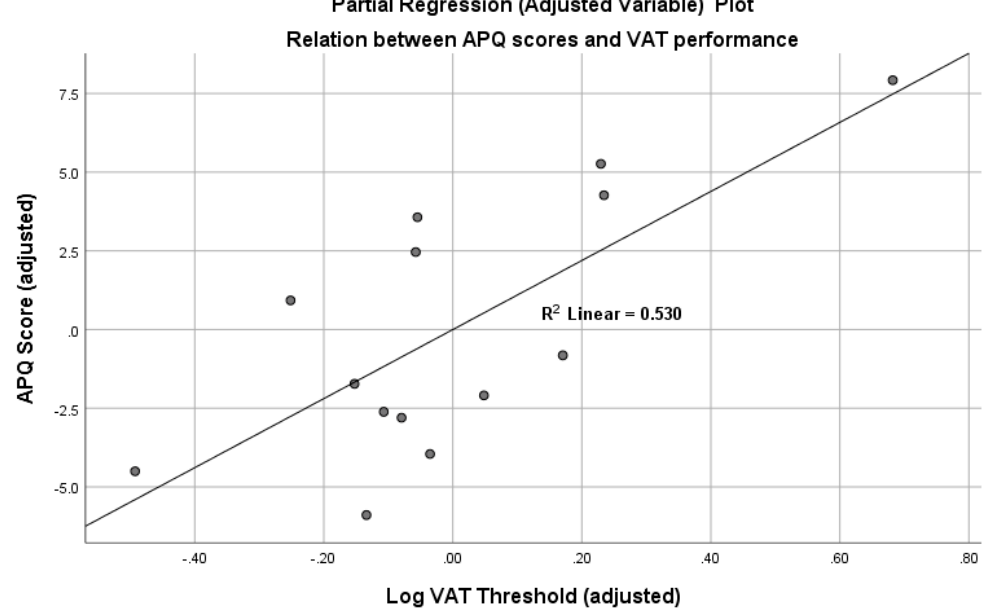
Figure 2. Partial regression (adjusted variable) plot, illustrating the relation between accident vulnerability (APQ scores) and individual differences in vision for action (log VAT thresholds), controlling for visual acuity (Freiburg Vision Test), age and gait performance (SPPB scores). (Note: plot exported from IBM SPSS Version 25, multiple regression output.).